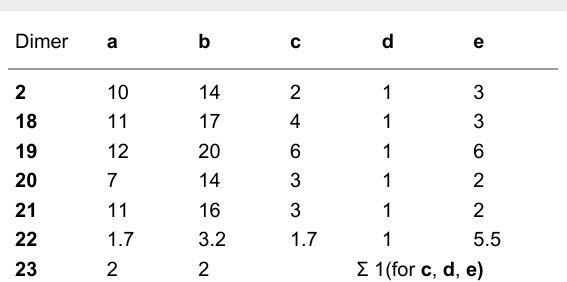
Table 6: Ratio a of the diastereomers a – e from the dimers 2 and 18 − 23 .